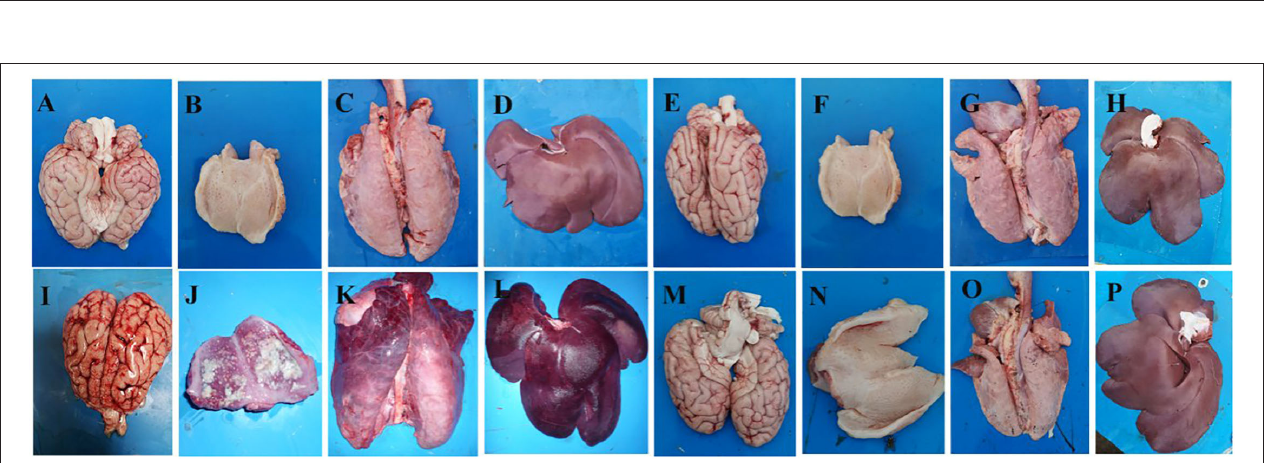
FIGURE 3 | Representative gross lesions in pigs after challenge with the vPRV/XJ-5 strain. (A–D) : Bartha-K61 vaccinated/challenged pigs; (E–H) : rPRV/XJ5-gI − /gE − /TK − prototype vaccine immunized/challenged pigs; (I–L) : Challenge-only pigs; (M–P) : Mock pigs; (A,E,I,M) : Brain; (B,F,J,N) : Tonsil; (C,G,K,O) : Lung. ( D,H,L,P ): Liver.